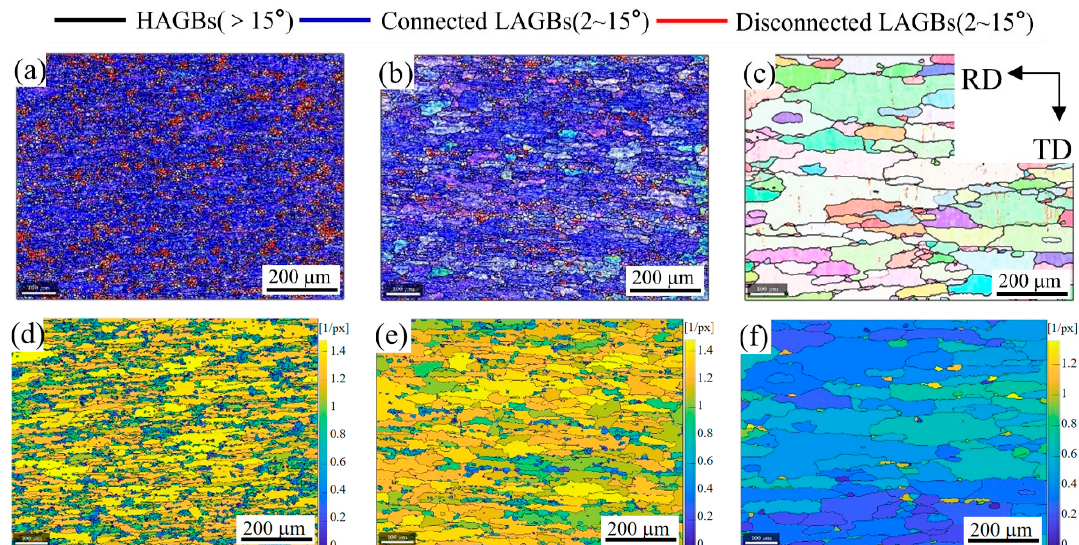
Figure 5. Grain boundary images of the 2A14 Al alloy on the RD-TD plane during annealing to ( a ) 505 °C, ( b ) 555 °C, and ( c ) 580 °C. Grain boundary density images of the 2A14 Al alloy on the RD-TD plane during annealing to ( d ) 505 °C, ( e ) 555 °C, and ( f ) 580 °C.